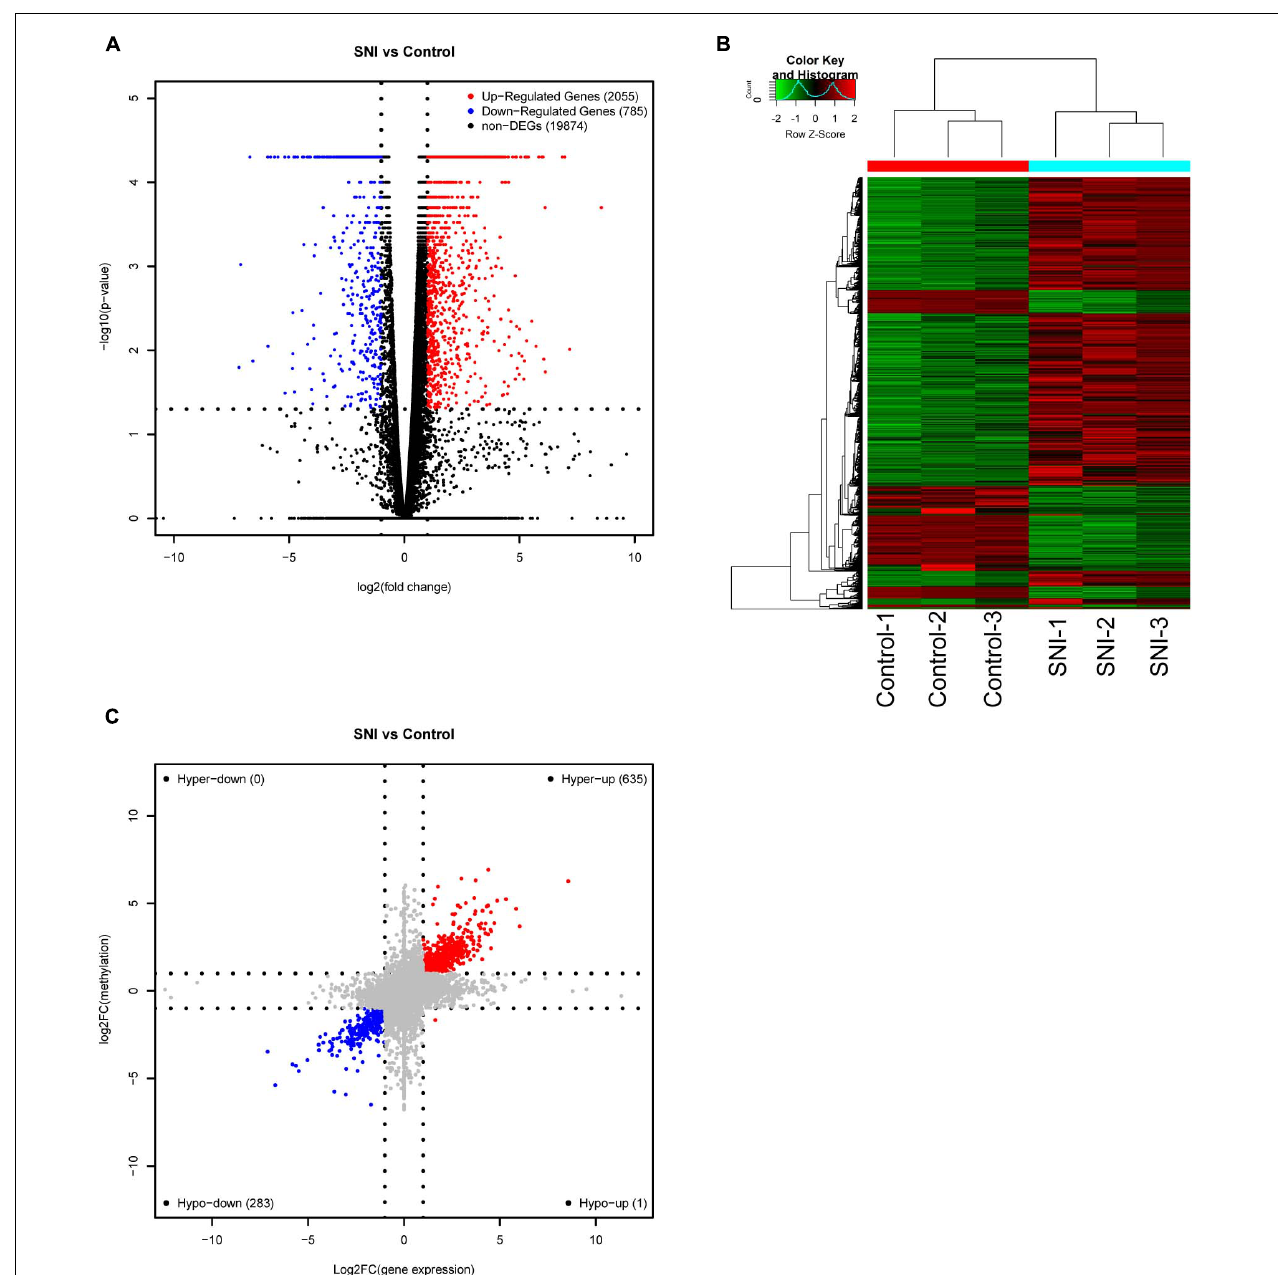
FIGURE 4 | Conjoint analysis of m6A methylation and mRNA expression after SNI. (A) Volcano plots and (B) Heatmap plots displaying the differentially expressed genes between SNI and control groups. (C) Four-quadrant graph showing the association between mRNA m6A methylation and transcriptome level.